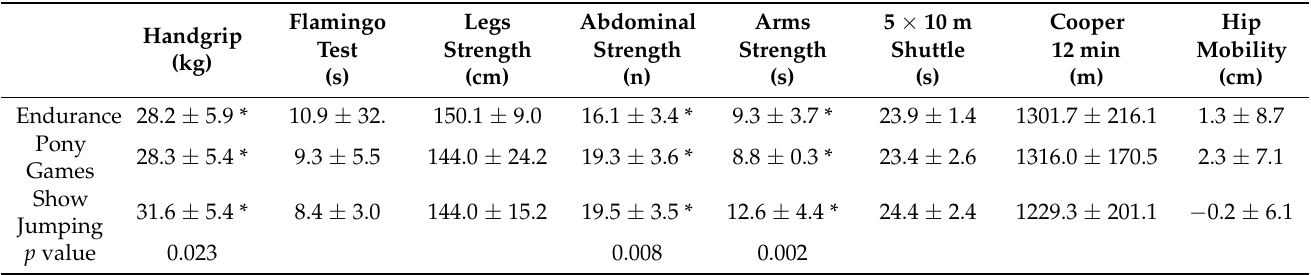
Table 4. Fitness values of riders for each equestrian